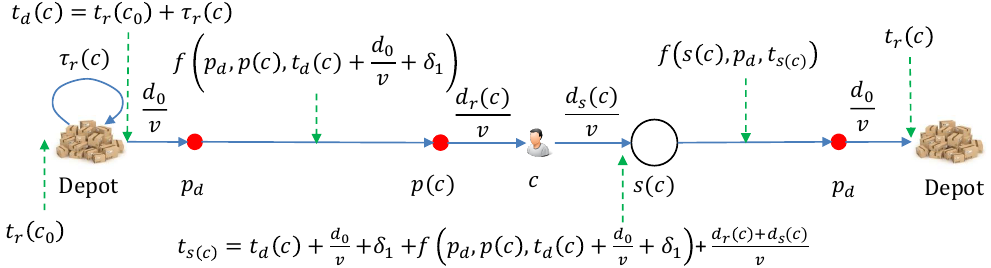
Figure 3. An illustration to compute the several key time instants and intervals for the drone–vehicle scheme. Here the superscript dv is not displayed as this only suits the drone–vehicle scheme.